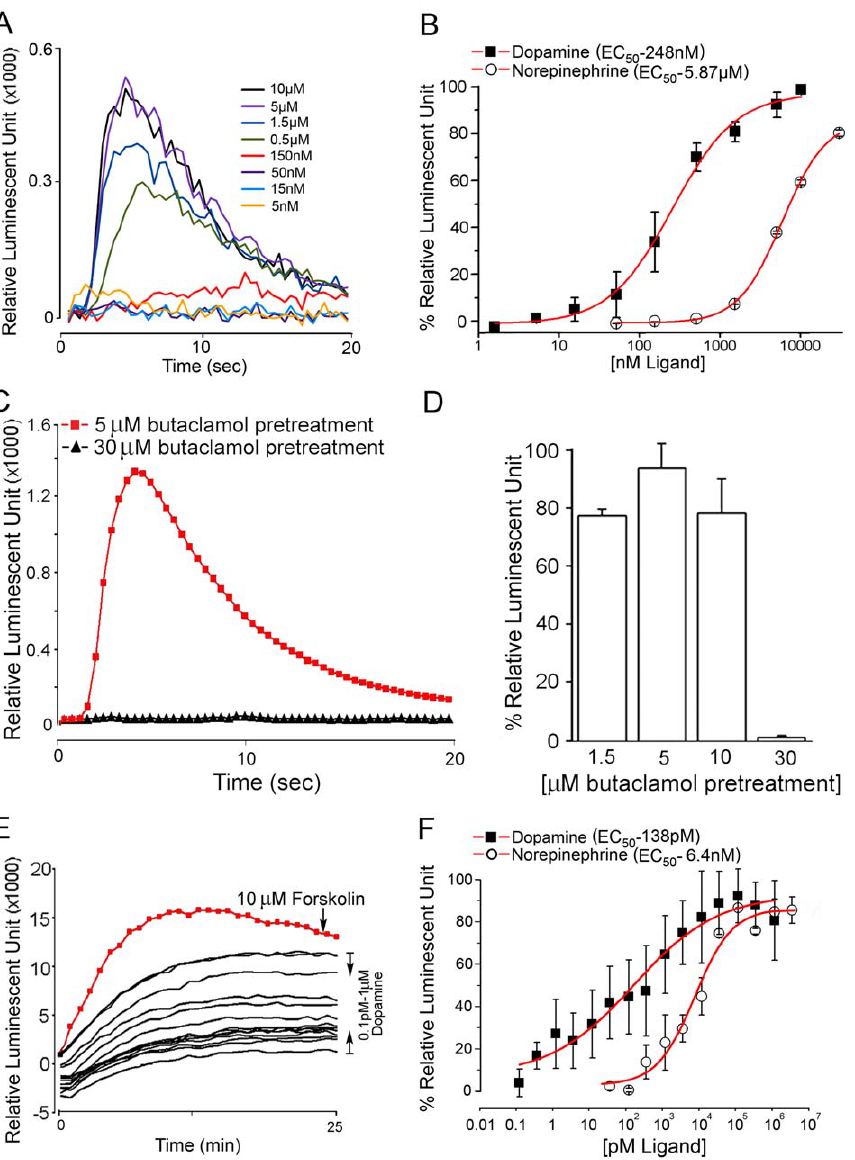
Figure 6. Reporter assays for D1 receptor showing DA-activated calcium mobilization and cAMP elevation. (A) Luminescent reporter calcium assay showing typical responses to varying doses (5 nM to 10 m M) of DA. (B) Dose–response curves of the CHO cells transfected with the D1 and aequorin constructs and treated with DA and norepinephrine. Antagonistic effect of butaclamol on the D1 receptor. (C) Luminescent responses to DA (3.3 m M) in the CHO cells expressing D1 receptor and aequorin. The cells were pretreated with 5 or 30 m M butaclamol (red and black lines, respectively) for 15 minutes. (D) Percent responses to DA (3.3 m M) when the cells were pretreated with different concentrations of butaclamol. Note that only 30 m M butaclamol was effective in blocking the DA action on the D1 receptor. (E) Luminescent reporter cAMP assay (GloSensor) showing typical responses to varying doses (0.1 pM to 1 m M) of DA. (B) Dose–response curves of the HEK cells transfected with the D1 and GloSensor constructs for DA and norepinephrine. Bars indicate standard errors for a minimum of four replicated